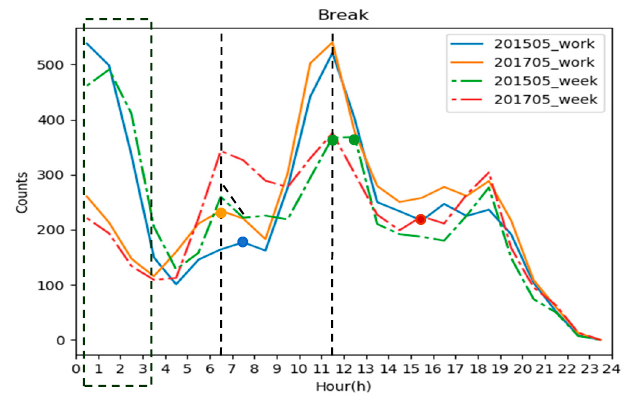
Figure 8. The quality of unoccupied trips longer than 1 h, by hours.